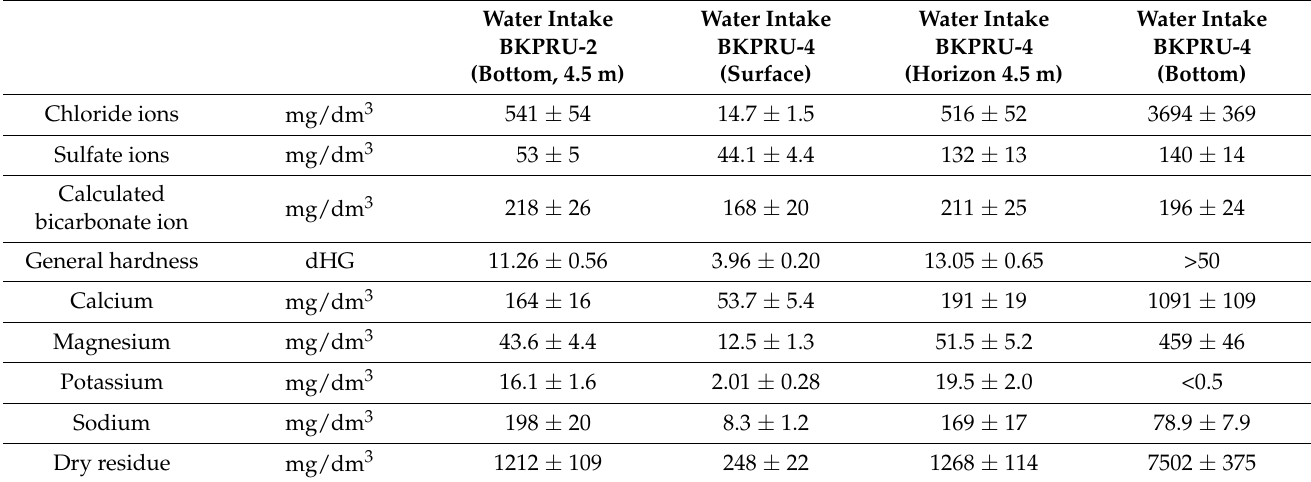
Table 1. The results of the chemical analysis of water samples taken by the Mining Institute of the Ural Branch of the Russian Academy of Sciences during the winter dry season on 25 March 2020 from the Verkhne-Zyryansk reservoir.